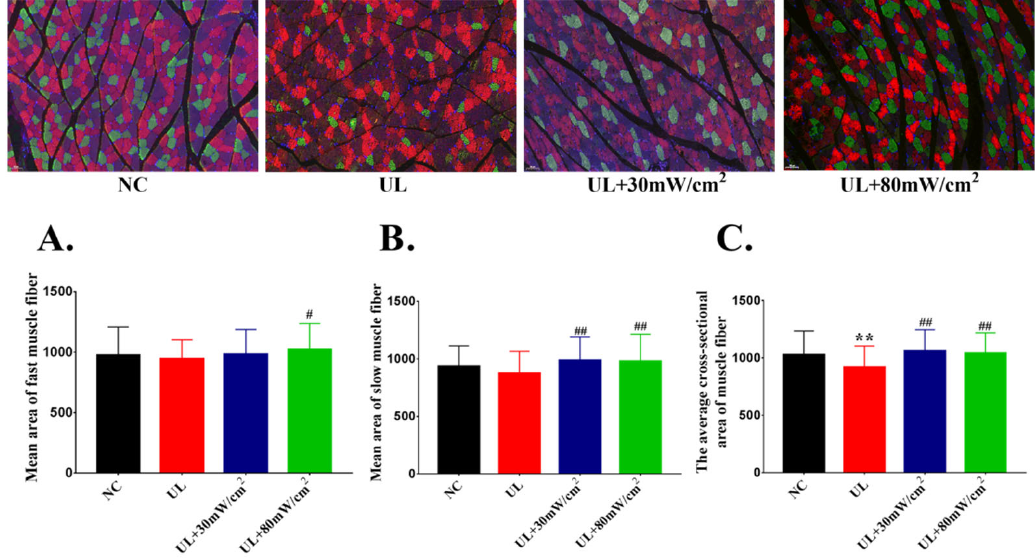
Figure 2. ( A ) The average cross ‐ sectional area of fast muscle fibers. ( B ) The average cross ‐ sectional area of slow muscle fibers. ( C ) The mean area of gastrocnemius muscle fiber. The data were ex ‐ pressed as mean ± SD ( n = 8 in each group), ** p < 0.01 vs. NC group, ## p < 0.01 vs. UL group, # p < 0.05 vs. UL